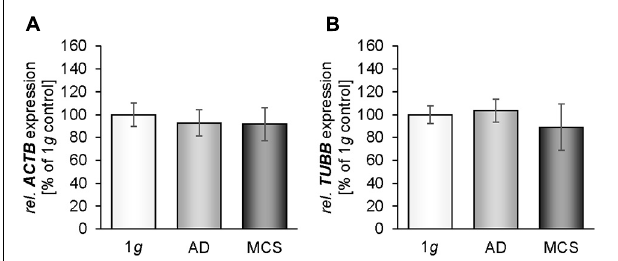
FIGURE 2 | Gene expression [ ACTB (A) , TUBB (B) ] of MDA-MB-231 cells exposed to the RPM. * p < 0.05 1 g vs. adherent (AD) and/or MCS and # p < 0.05 AD vs. MCS.